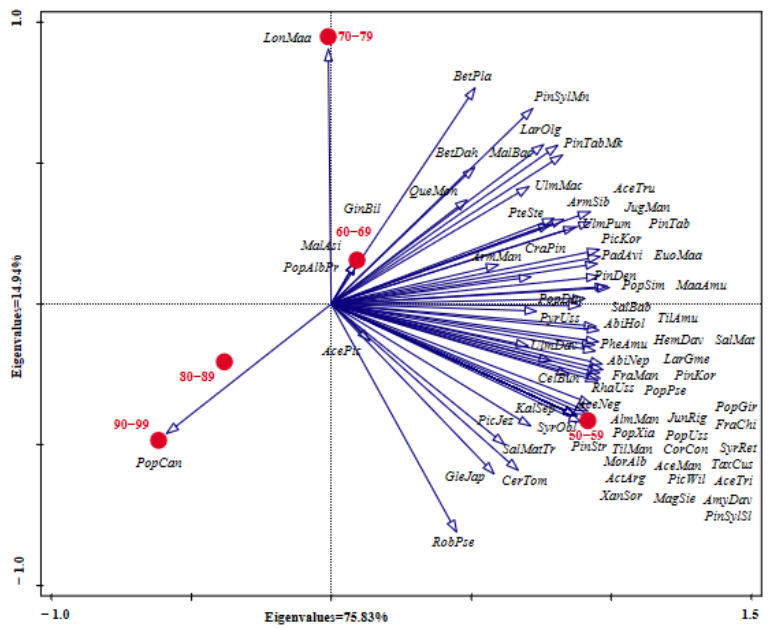
Figure 5. PCA analysis of the species composition among different age classes (years). For abbrevi- ations of species names, refer to Table A1. tions of species names, refer to Table